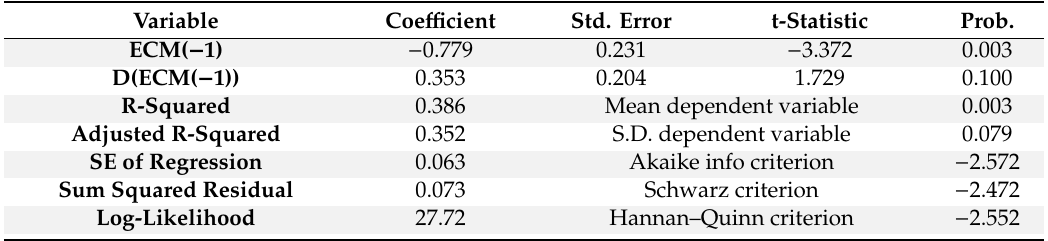
Table 4. ADF unit root test on ECM.